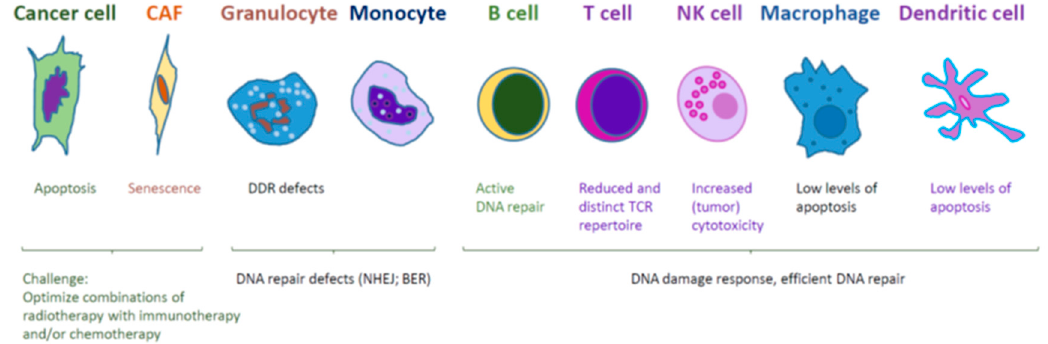
Figure 4. Summary. Effects of radiation on cancer cells, CAFs and immune cells. Combination of immunotherapy and radiotherapy, or a combination of different radiation regimens, is a possible direction to improve treatment efficiency. Depletion of CAFs by combining radiotherapy and chemo- or immunotherapy might reduce pro-tumorigenic and immunosuppression activities. Monocytes and granulocytes lack NHEJ and BER DNA repair factors and hypersensitive to radiation. B cells, T cells, NK cells, macrophages and dendritic cells possess e ffi cient DDR and DNA repair and show distinct responses to